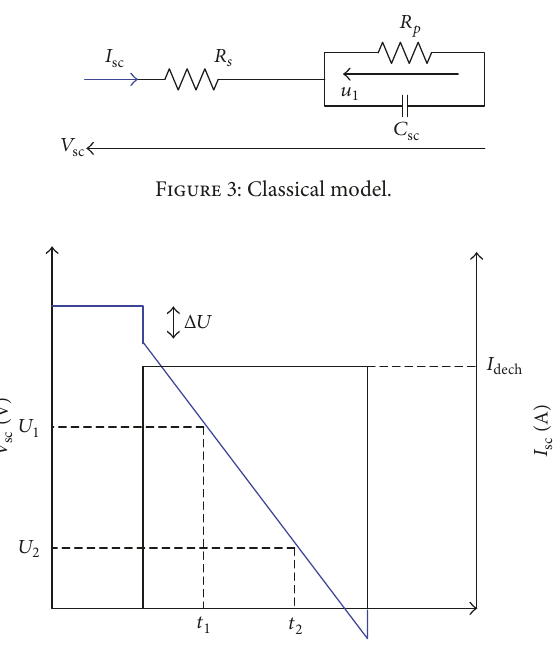
Figure 4: Evolution of voltage discharged with a constant